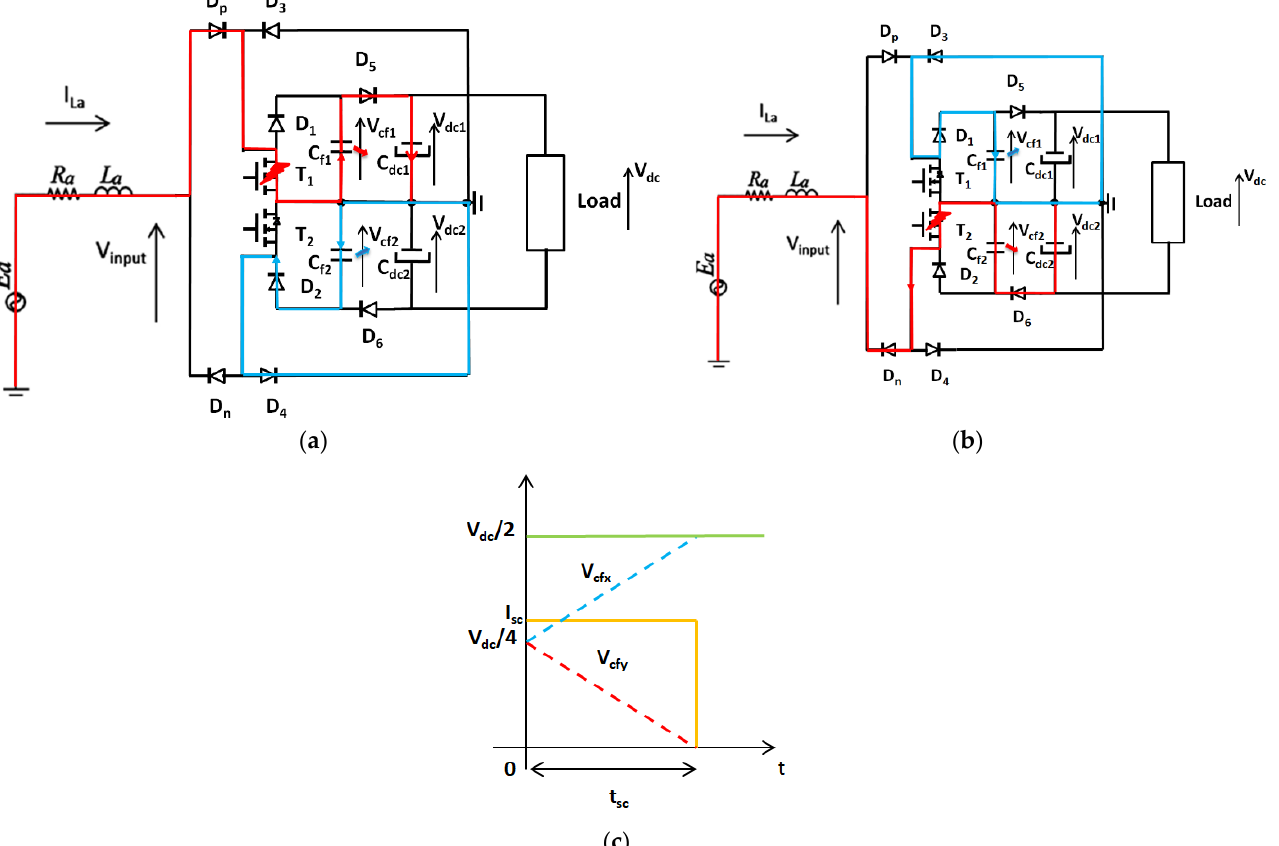
Figure 2. Current flow paths under SCF. ( a ) T1 is short-circuited, ( b ) T2 is short-circuited, ( c ) local behavior following an SCF ( x corresponds to a faulty cell, y corresponds to a nonfaulty cell; x , y ϵ (1; 2)).